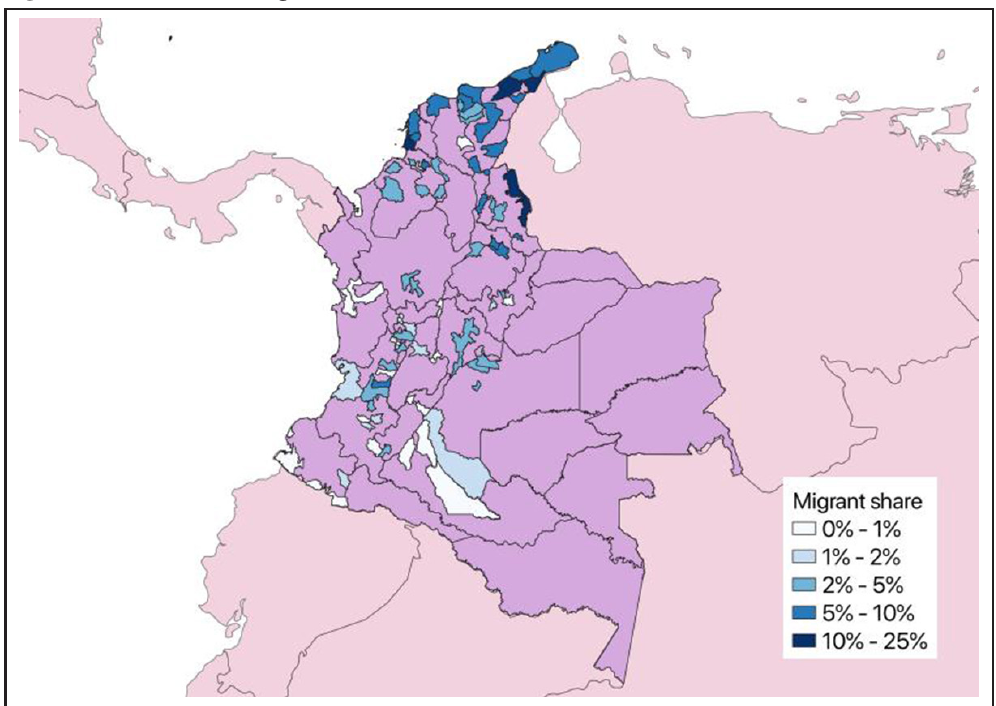
Figure 2 Venezuelan migrants in Colombia